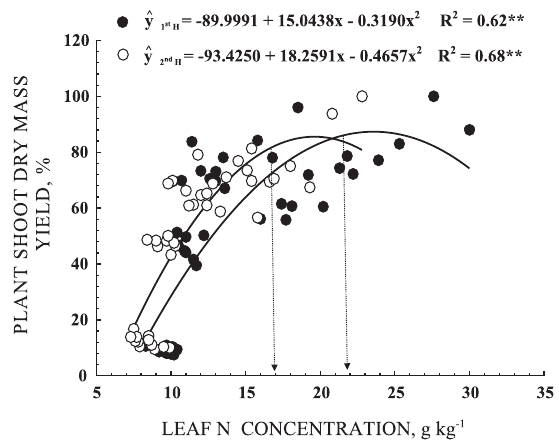
Figure 9. Relationship between newly expanded lamina leaf (NL) N concentration and plant top dry mass yield, in the first ( ) and second ( ) growth of the ‘Mombaça’ grass. Solid lines indicate the leaf N concentration corresponding to 90 % of maximum